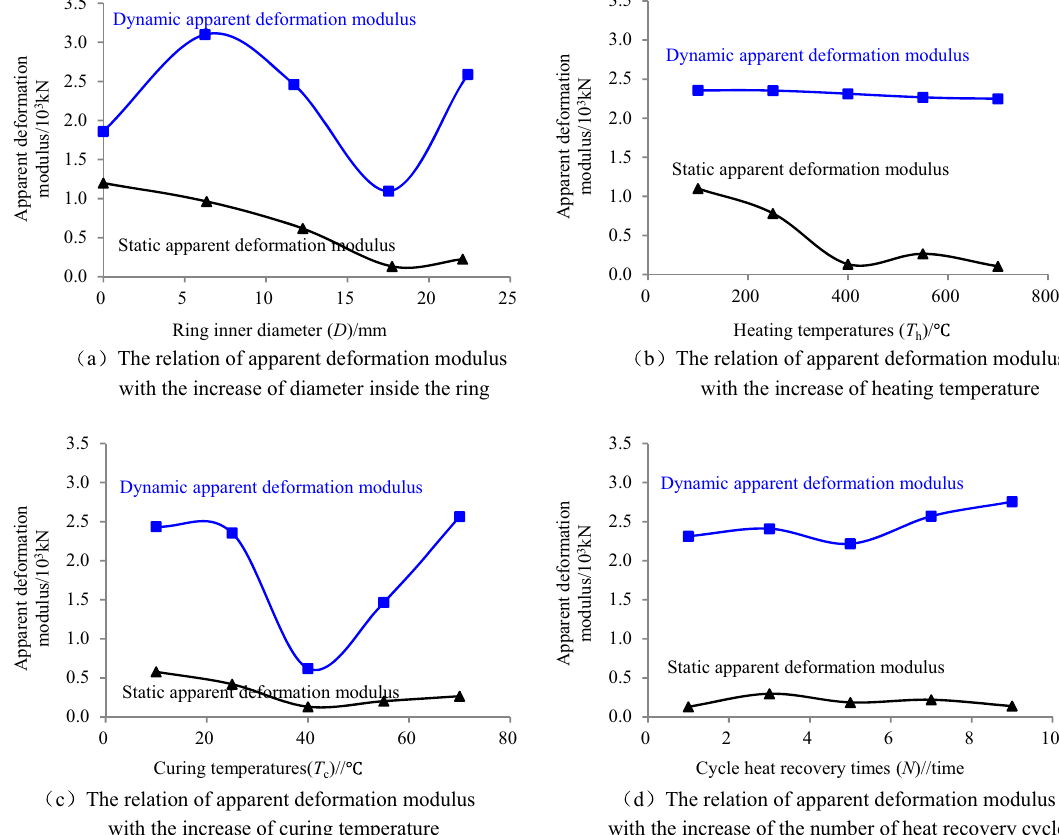
Figure 4. Relationship between apparent deformation modulus and ring inner diameter, heating temperature, curing water temperature and times of heat production cycle (The inner diameter of the rock samples are all about 18 mm in ( b – d